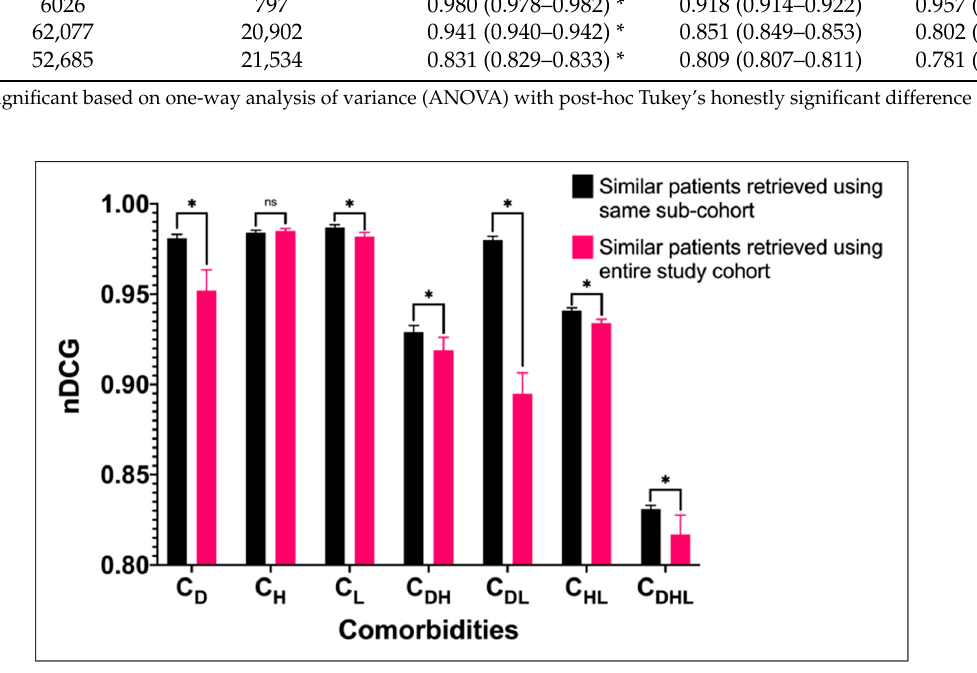
Figure 2. Comparison of nDCG@10 of the D3K approach when similar patients are retrieved using sub-cohorts and entire study cohorts. * indicates statistically significant based on paired t -test, while ns indicates not statistically significant. Two strategies for binning variable values are also compared. Our proposed method,